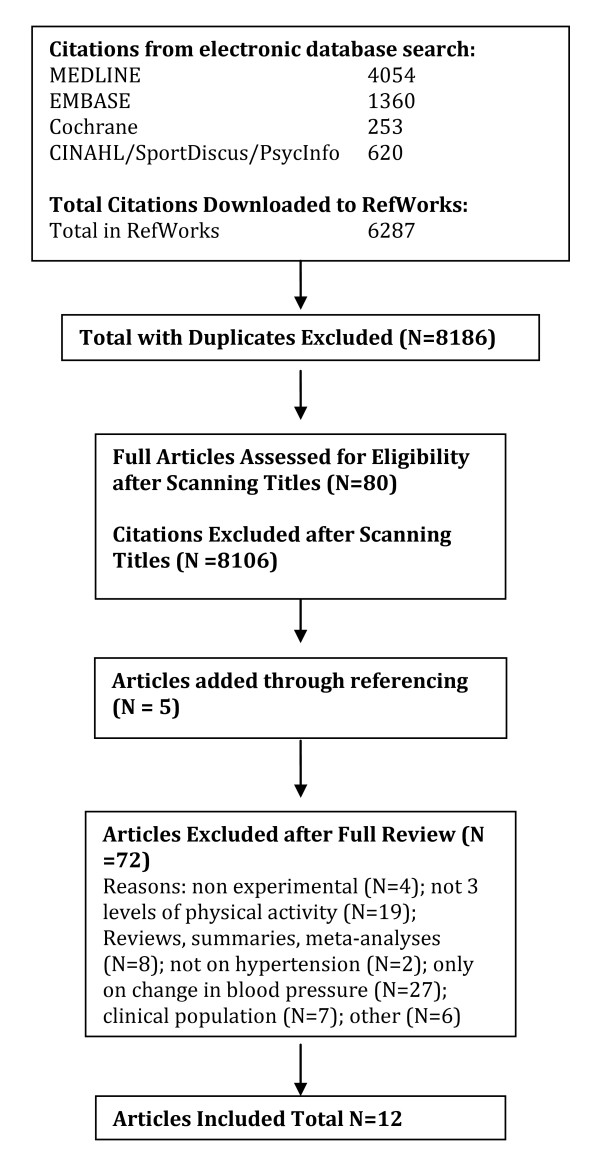
Results of the Literature Search for Hypertension.